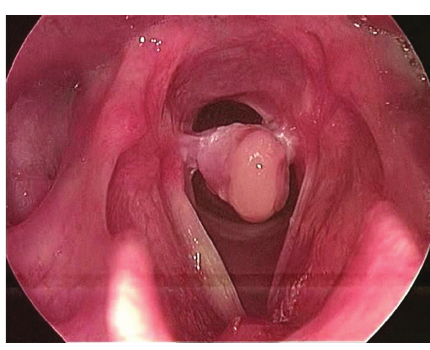
Figure 5: Post-Botox identification of interarytenoid